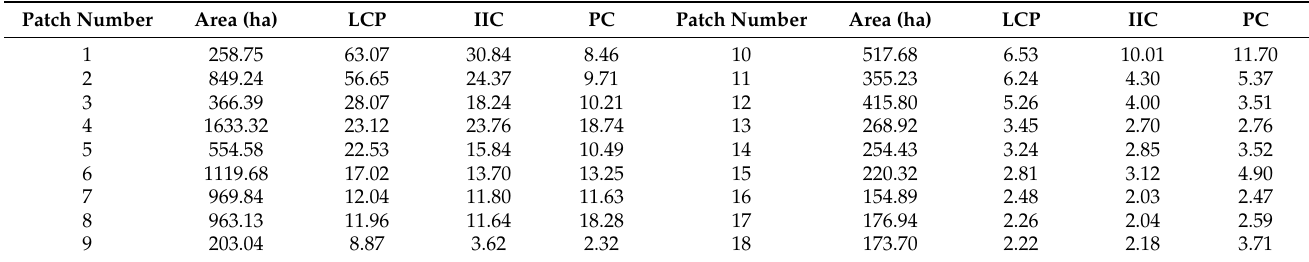
Table 6. Evaluation of the landscape connectivity index of the ecological source